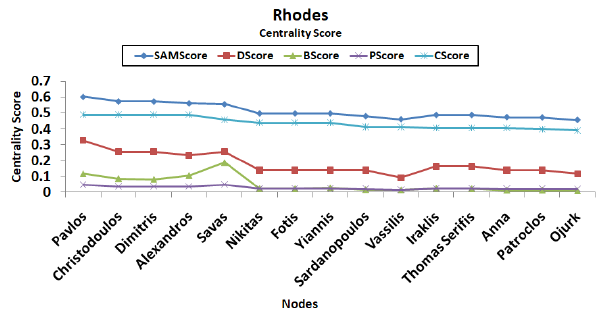
Figure 11. Centrality score of top 15 nodes from Rhodes dataset, sorted by SAM